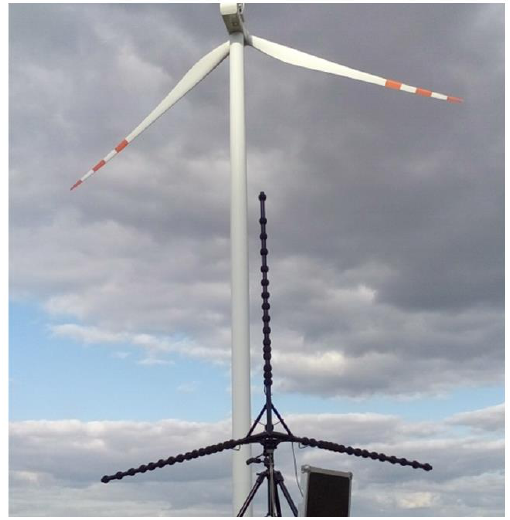
Figure 20. Image of acoustic camera during measurements